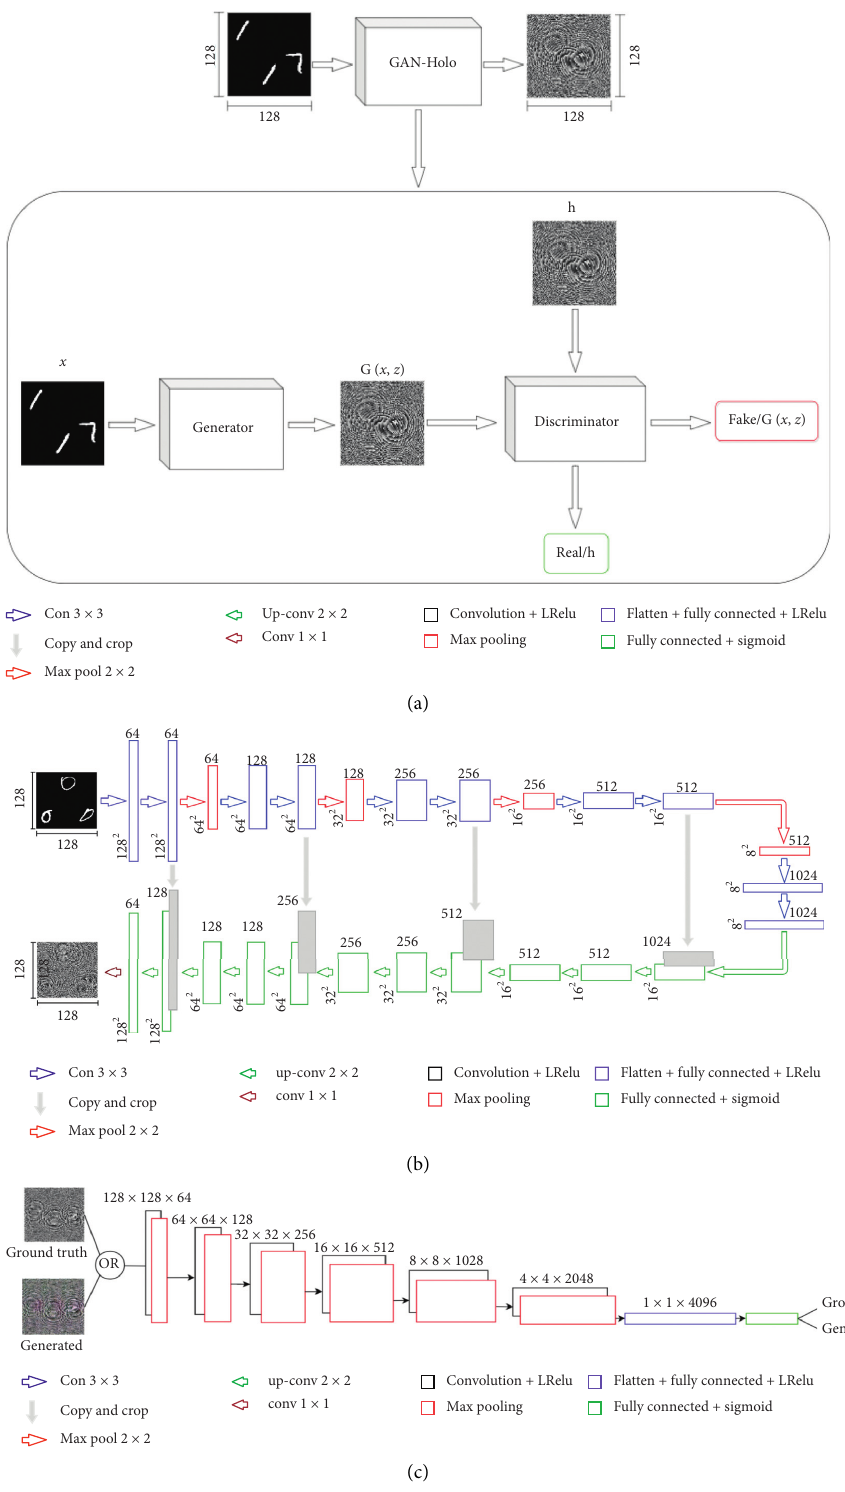
Figure 3: (a) The general structure of GAN-Holo; (b) generator; and (c)